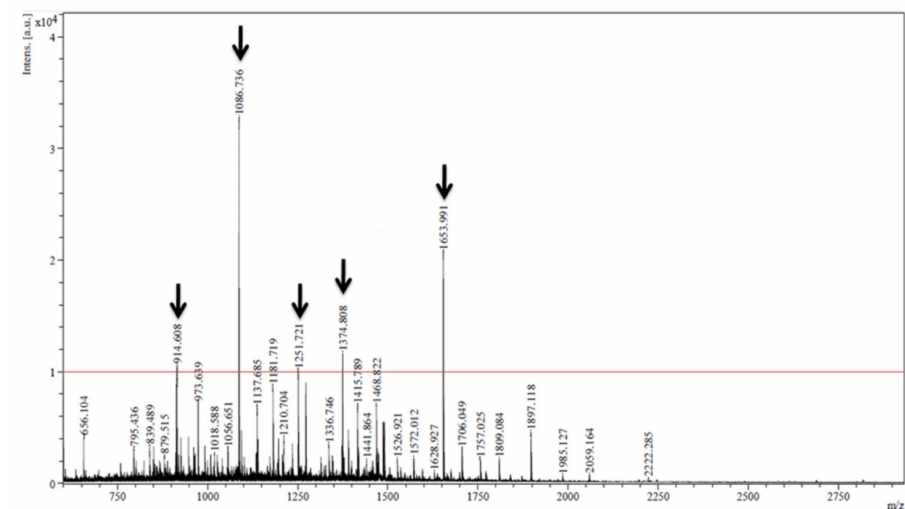
Figure 2. MALDI-ToF spectrum of the B. bengalensis protein hydrolysate of alcalase at 120 min. The arrows mark the peptides selected for the de novo sequencing. The red line across the spectrum marks the baseline intensity of 1 × 10 4 a.u.